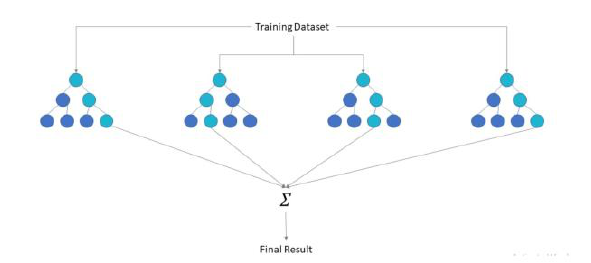
Figure 4 . The Random Forest framework